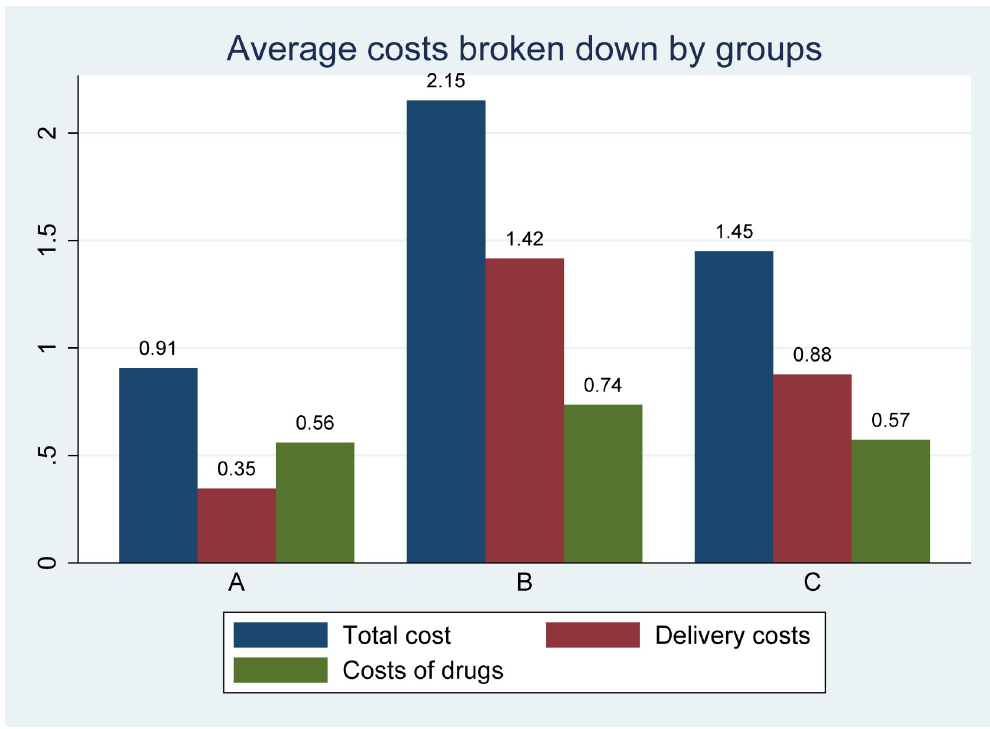
Fig 2. Total costs (US$) and costs divided in